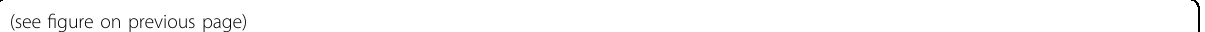
Fig. 4 Identi fi cation of endogenous proteins translated from full-length PC and alternatively spliced AS1, CERS2 transcripts in BT-474 cells. A Table representing the unique peptides corresponding to junction region for full-length (PC/FL, Exon 7 – 8) and spliced form (AS1/SF, Exon 7 – 9) of CERS2 proteins (NP = not present). B Diagrammatic representation of MS identi fi ed peptides corresponding to PC/FL- and AS1/SF-derived proteins. Dark red circle denotes the proteins identi fi ed by Peptide Shaker database and blue circles denote all shared peptides identi fi ed from the chymotrypsin digested samples in both PC/FL and AS1/SF proteins. Unique peptides covering the junction region for PC/FL or AS1/SF proteins are denoted by light red and green respectively. C MRM spectra for PC/FL (Exon 7 – 8) transcript-derived peptide (SIASDVKRKDF, 196 – 206 amino acids) showing daughter ions generated by fragmentation of parent ion (633.346Da m / z ). Inset showing distribution and intensity of daughter ions generated. D , E Peak area representing abundance of few selected daughter ions generated from parent ion (633.346Da m / z ) corresponding to PC/ FL. F MRM spectra for AS1/SF (Exon 7 – 9) transcript-derived peptide (SIASDVKRKSAKMF, 196 – 209 amino acids) showing daughter ions generated from the parent ion (784.434 Da m / z ). Inset showing distribution and intensity of daughter ions generated. G , H Peak area representing abundance of few selected daughter ions as quanti fi ed from parent ion (784.434 Da m / z ) corresponding to AS1/SF protein (PC/FL = protein coding/full-length; AS1/SF = alternatively spliced 1/spliced